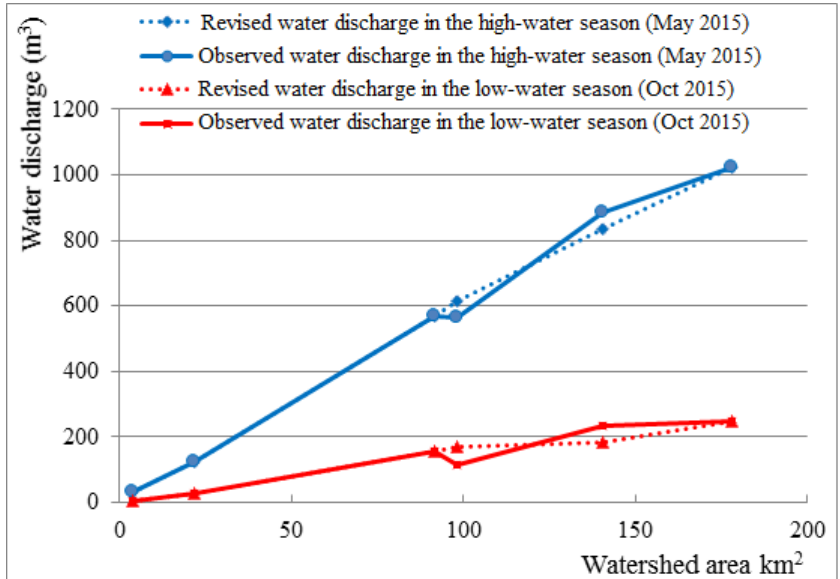
Figure 4. Water discharge at the monitoring points both in the high-water and low-water seasons.